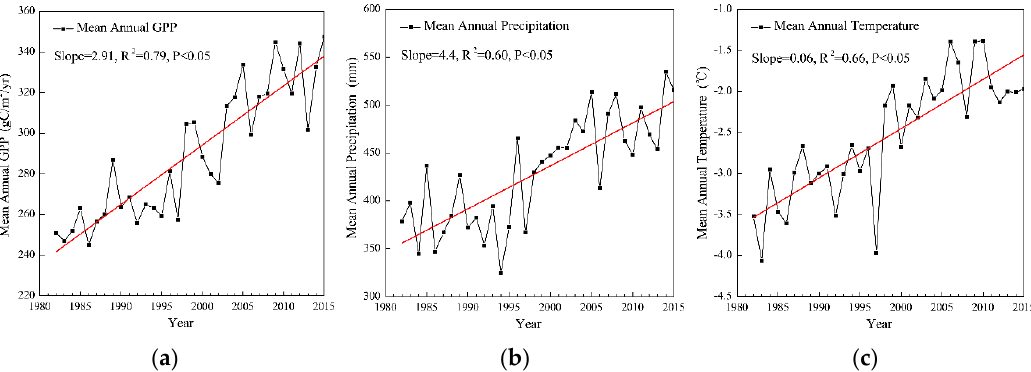
Figure 9. Interannual variations of different factors of alpine grasslands on the TP from 1982 to 2015. ( a ) Mean annual GPP; ( b ) Mean annual precipitation; ( c ) Mean annual temperature.